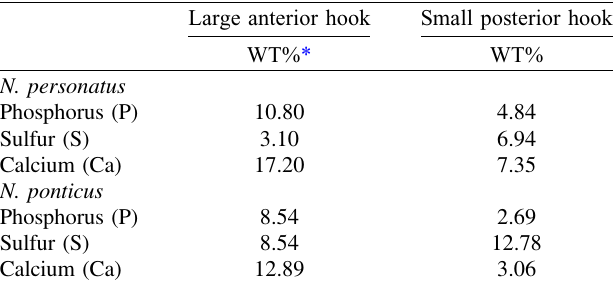
Table 4. Results of the X-ray microanalysis for elements present in the intact hooks of two species of Neoechinorhynchus , N. personatus from Mugil cephalus in the Mediterranean off Tunisia and N. ponticus from Chelon auratus in the Black Sea.